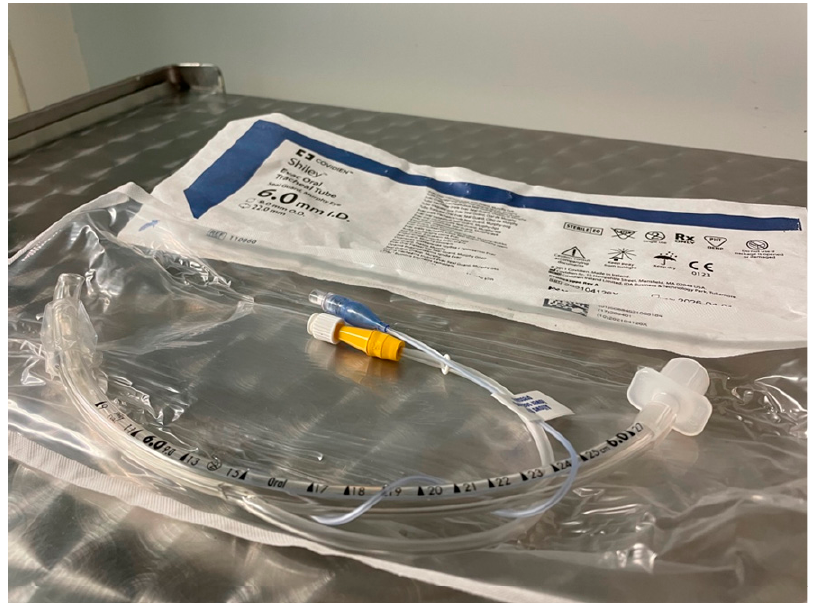
Figure 2. Cuffed tube with the subglottic secretion suctioning .